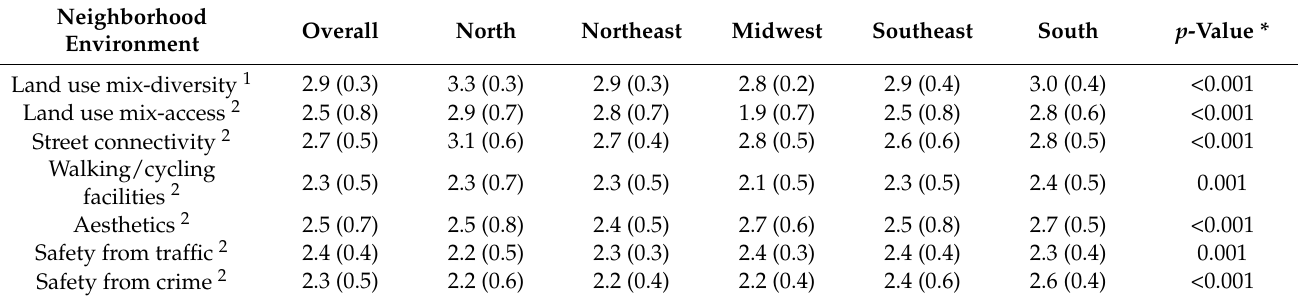
Table 2. Overall and regions specific perceived environment